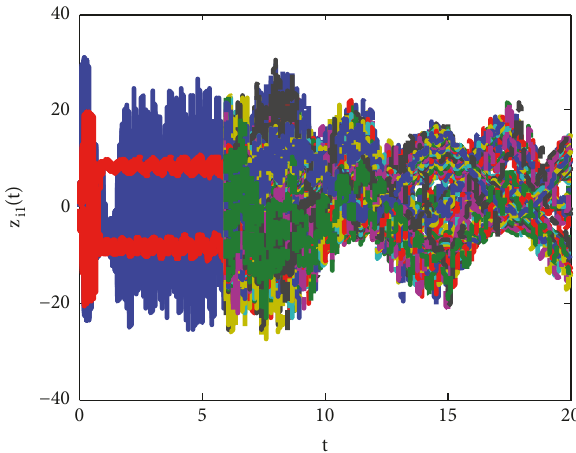
Figure 5: (Color online) Evolution curves of state variables 𝑧 𝑖1 (𝑡) after adding control.